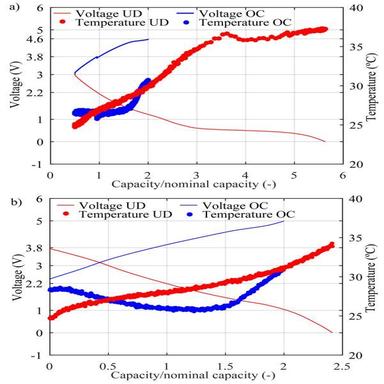
Voltage and temperature evolution during abuse tests. a) OC/UD of pouch cells; b) OC/UD of prismatic cells.